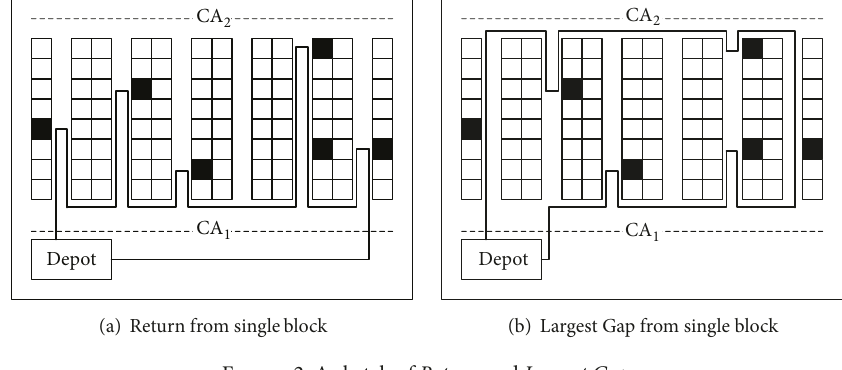
Figure 2: A sketch of Return and Largest Gap .